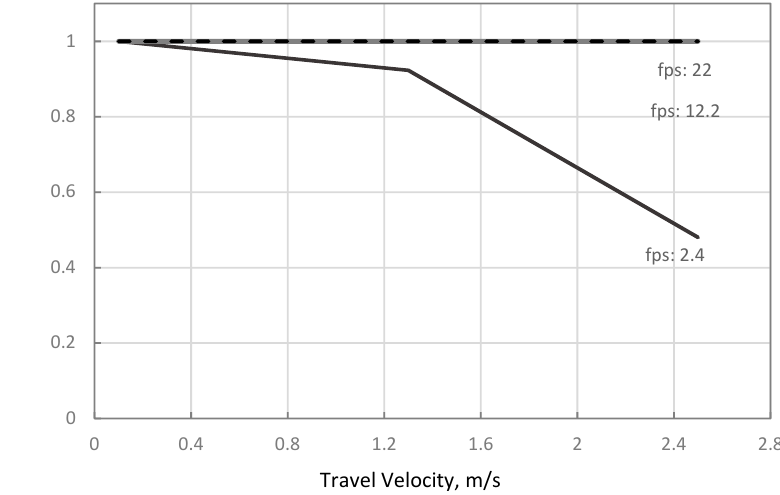
Figure 9. Simulated plant hill detection rates of the vision system moving at 2.4, 12.2, and 22 fps at different travel velocities.